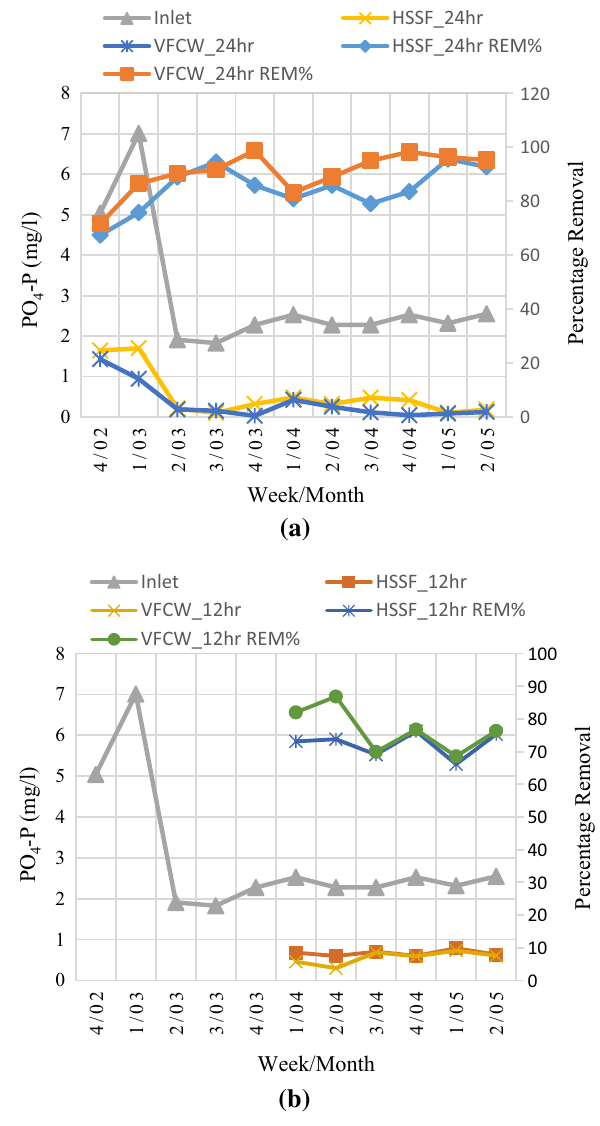
Fig. 8 a Phosphates (PO 4 –P) influent, effluent concentration and percentage removal of HSSF-CW and VFCW for 24-h HRT, b phosphates (PO 4 –P) influent, effluent concentration and percentage removal of HSSF-CW and VFCW for 12-h